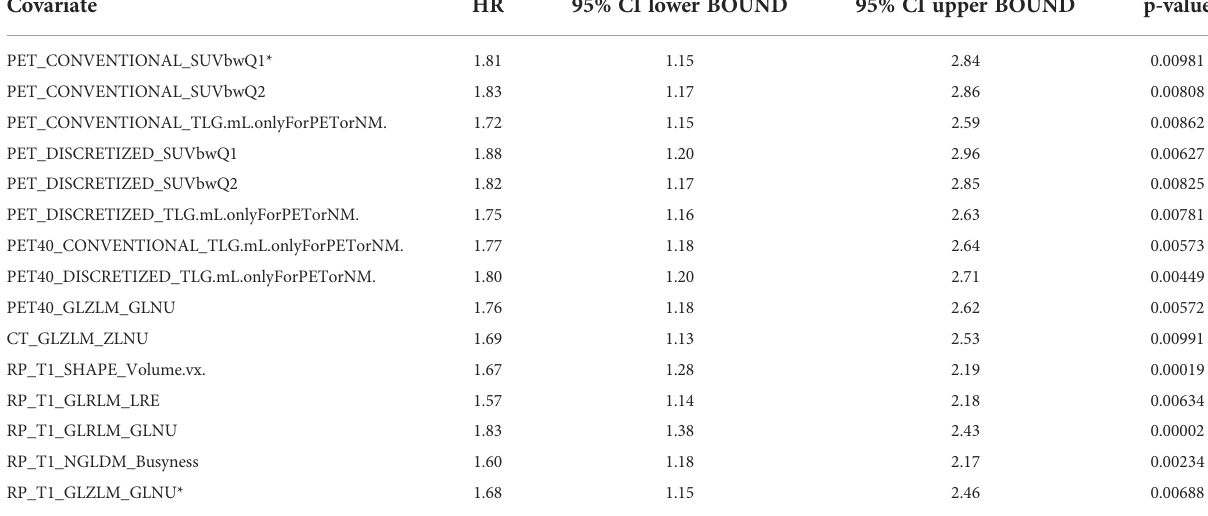
TABLE 3 Feature selection for OS. Covariate